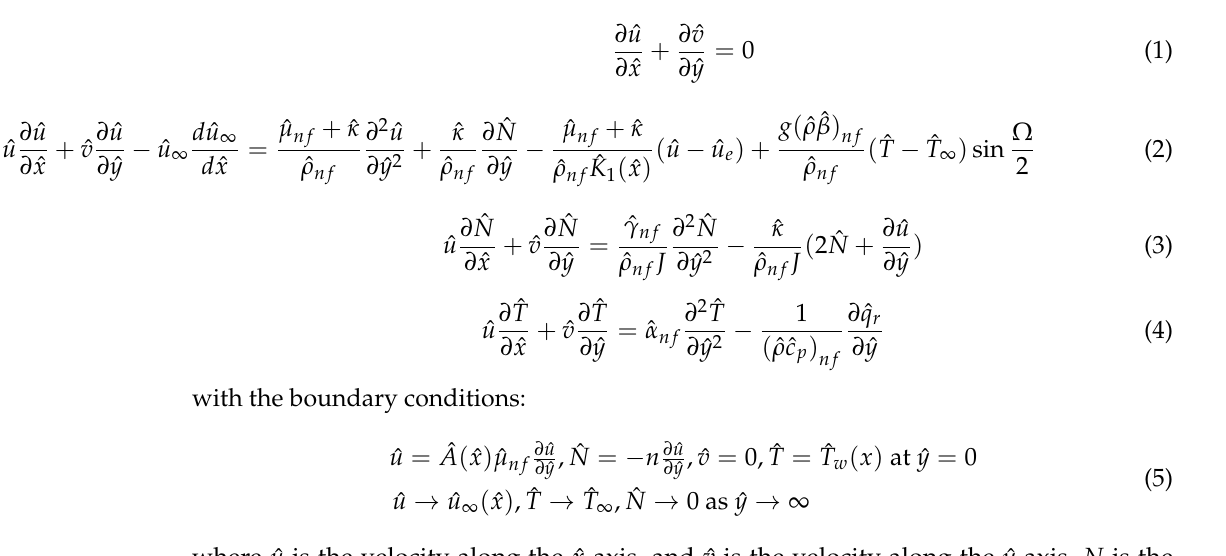
Table 1. Thermo-physical properties of base fluid and nanoparticles [16]. Base Fluid Silver Properties (Sodium Alginate) (Ag) Density, ρ (kg/m 3 ) 989 10,500 Specific heat, c p (J/kg-K) 4175 235 Thermal conductivity, k (W/m-K) 0.6376 429 Prandtl number, Pr 6.5